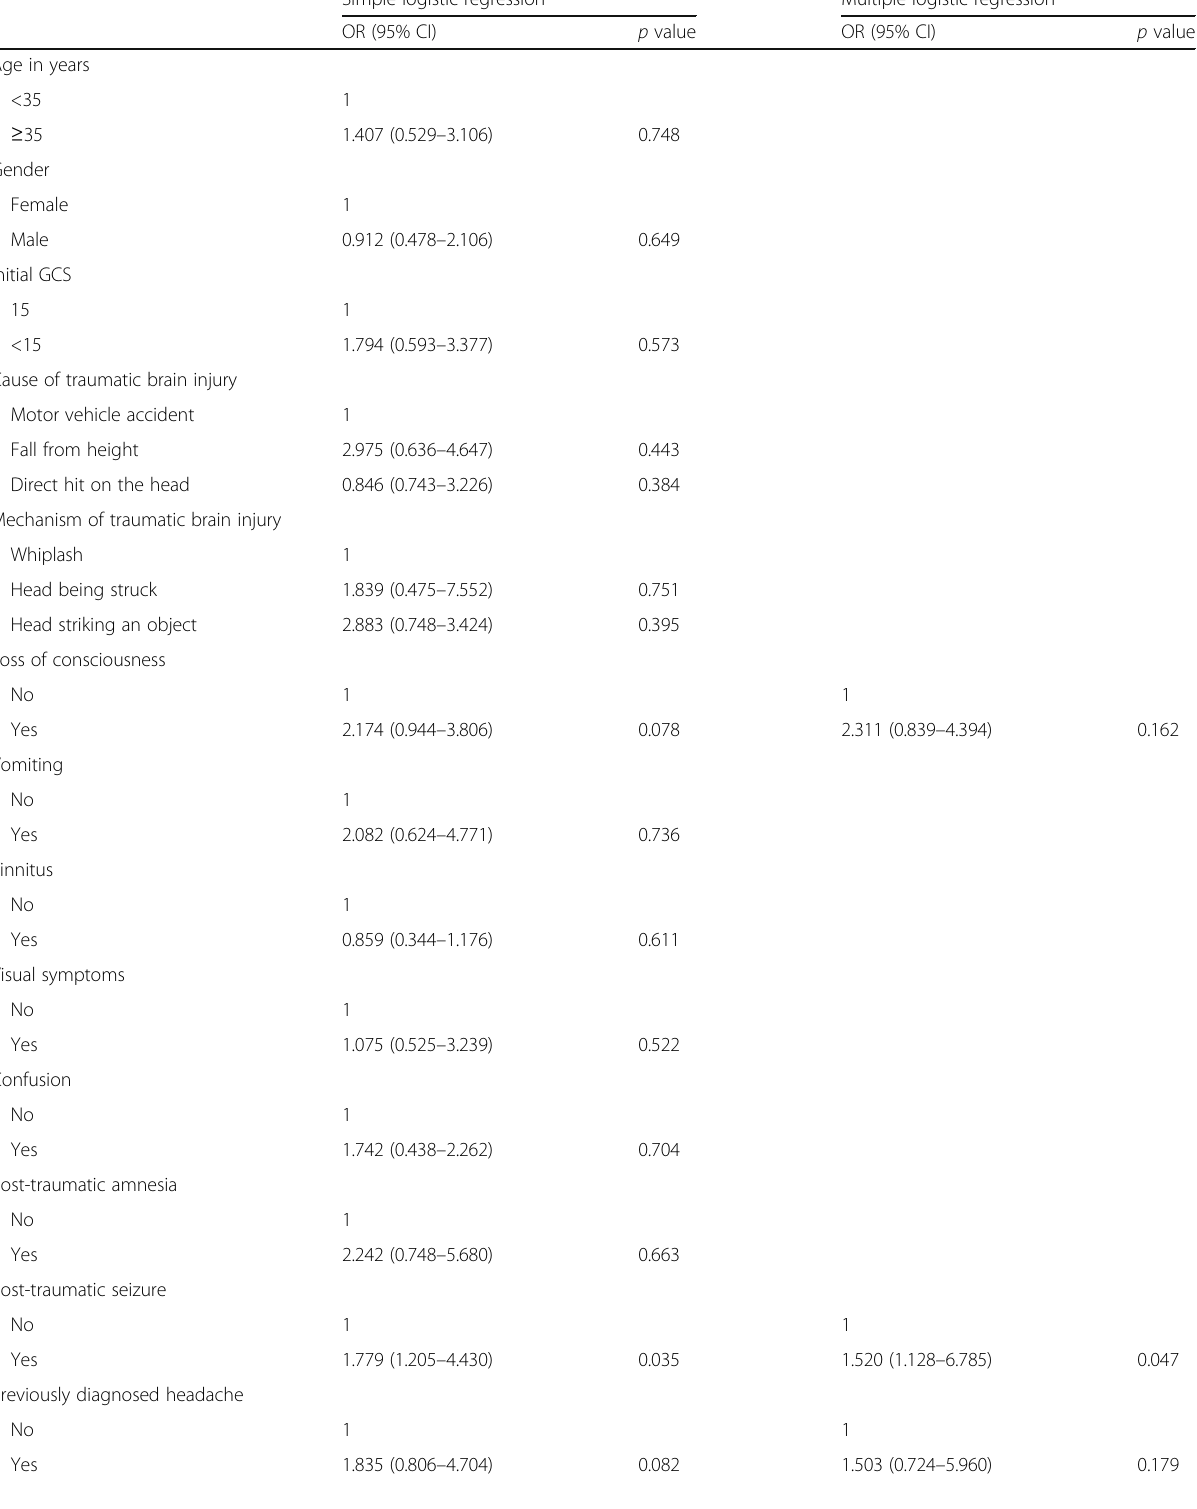
Table 2 Risk factors for moderate-to-severe headache at the 12-month